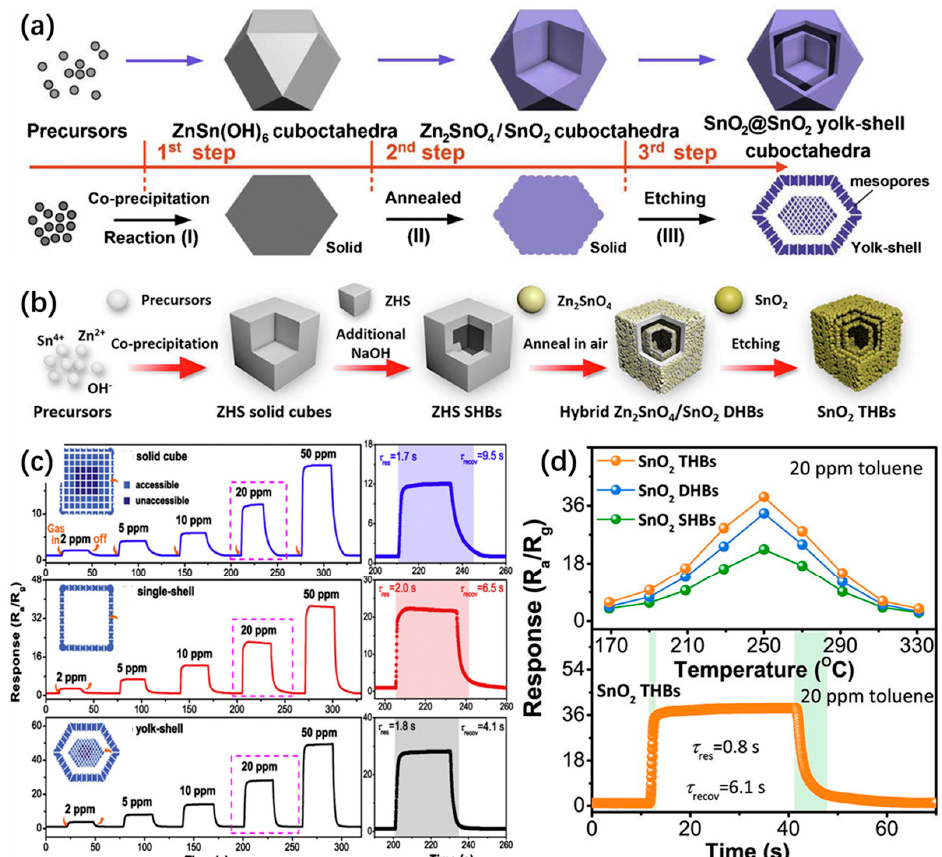
Figure 6. Structures and gas-sensing performance of SnO 2 . Schematic illustration for the formation of ( a ) yolk-shell SnO 2 hollow structures and ( b ) SnO 2 THBs. ( c ) Dynamic sensing transients of three SnO 2 products to toluene with different concentrations. The right insets show the corresponding response time ( τ res ) and recovery time ( τ recov ) examined to 20 ppm toluene. ( d ) Response of sensors based on different SnO 2 nanostructures versus 20 ppm toluene concentration. The below part shows the τ res and τ recov examined to 20 ppm toluene for SnO 2 THBs. Panels ( a , c ): reproduced with permission from Ref. [120], © 2016 Elsevier B.V. Panels ( b , d ): reproduced with permission